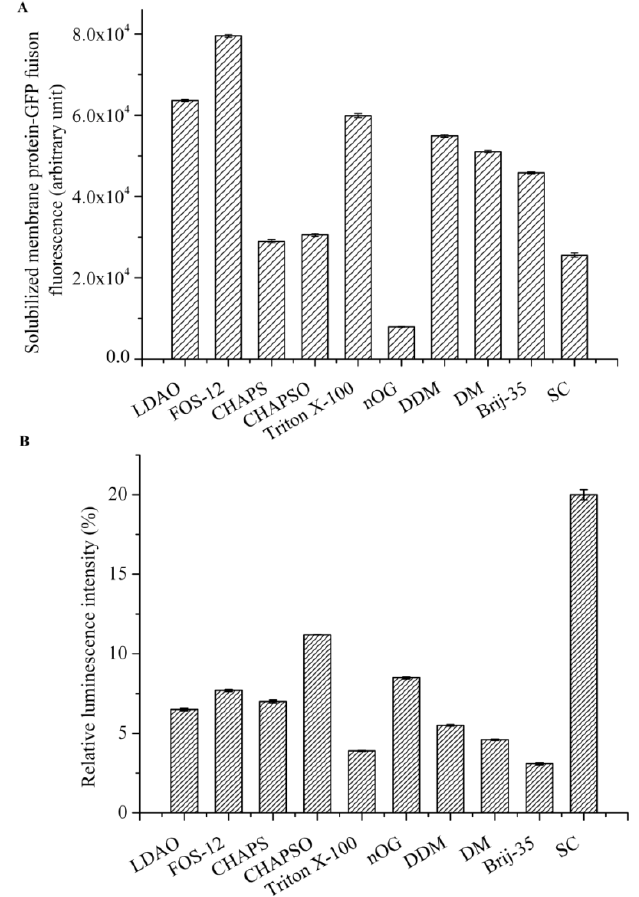
Figure 3. Detergents screening based on degree of cell membranes dissolution and level of kinase activity. ( A ) Comparison of different detergents for their ability to efficiently solubilize cell membranes. Different detergents (10× critical micelle concentration (CMC)) were separately added to cell membrane suspensions. After ~2 h of solubilization on ice, the suspensions were centrifuged at 200,000× g for 50 min at 4  C, and then GFP fluorescence intensity of the 200 μ L supernatant aliquots were measured on a spectrofluorometer; ( B ) The effect of different detergents on AgrC kinase activity. As a negative control, a kinase reaction was performed in the absence of AgrC. Luminescence was recorded on a Synergy2 Multi-Mode Microplate Reader. Relative luminescent intensity was expressed as a % control reaction. Values represent the mean ± S.D. of three replicates of three independent